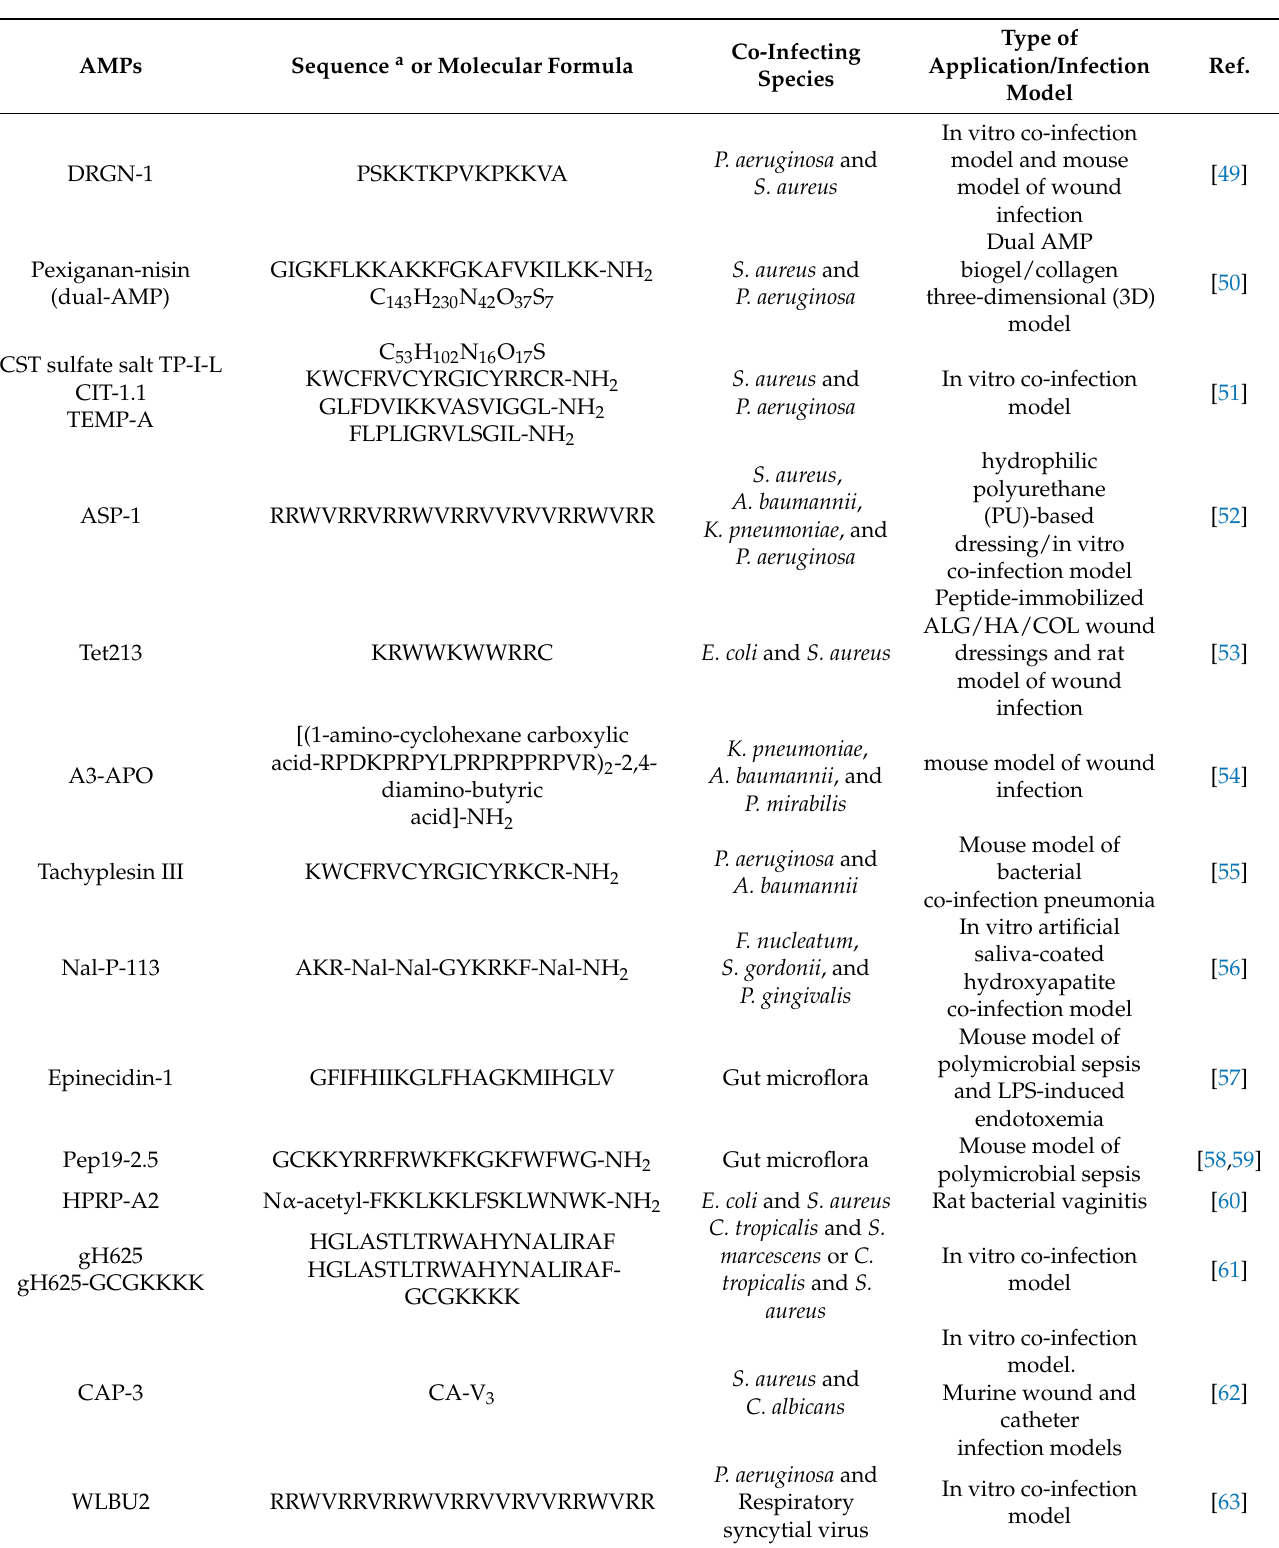
Table 3. Examples of AMPs tested against mixed